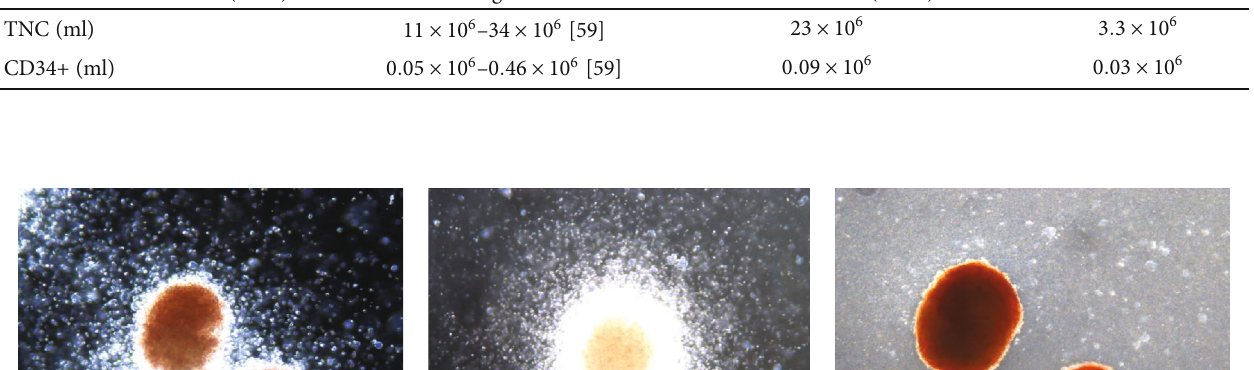
Table 3: Comparison of the HSC procured from living and deceased donor iliac crest bone marrow. Bone marrow: iliac crest ( n = 7 )